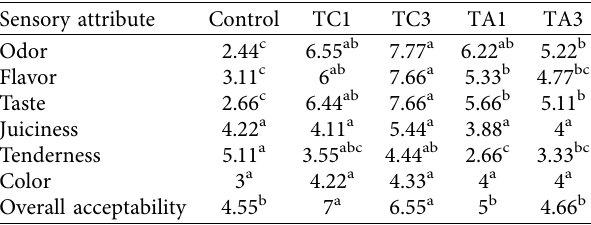
Figure 6: Sensory assay of meat samples treated with T. algeriensis EO. Table 2: Mean (standard deviation) of sensory attributes of minced beef meat